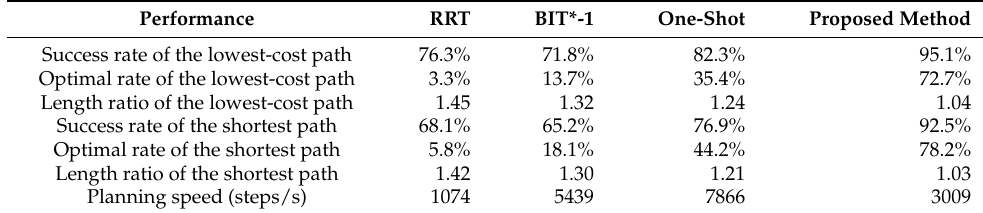
Table 6. Performance of different path-planning